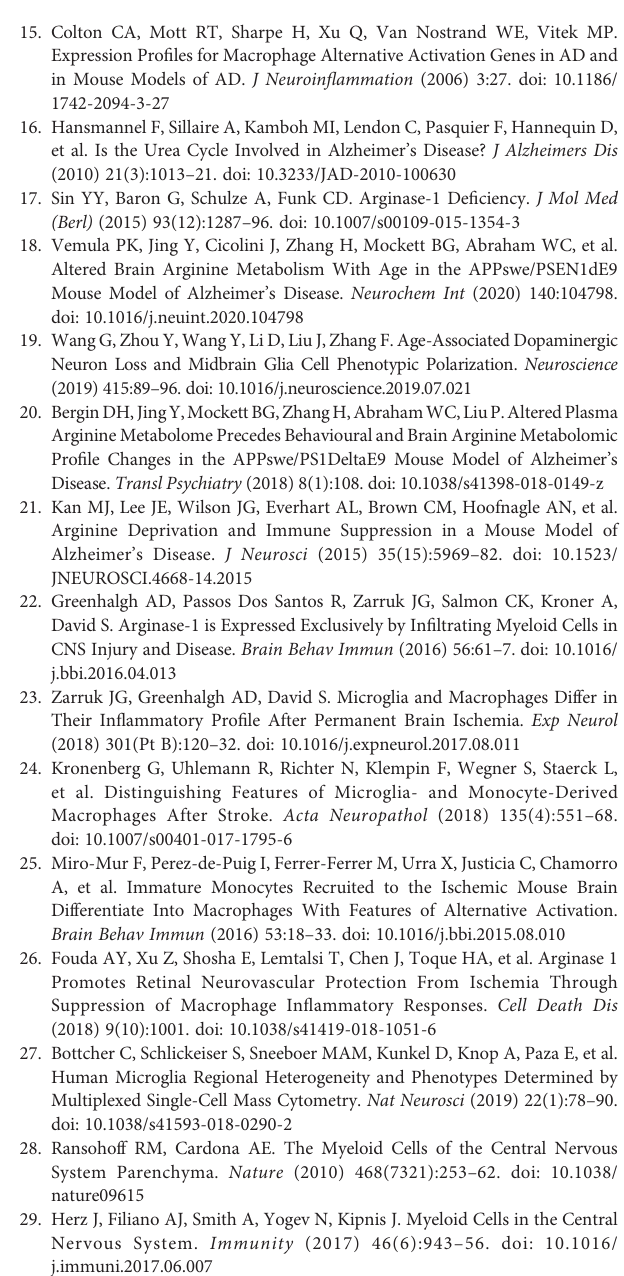
unsupervised clustering of 770 genes. All data passed QC metrics without any fl ags (top bar, yellow). Genes expressed below the background threshold are fl agged in blue.Theorangeorbluecolorintheheatmapindicateshighorlowgeneexpression z -score of each sample. All scores are presented on the same scale via a z - transformation. (B) Principal components of all normalized data. The principal component analysis shows the four groups ’ variance using the four leading componentsbasedonallnormalizeddata. (C) Aheatmapofcorrelation matrixofall signature pathways from pathway scoring analysis was presented. Yellow and blue colors indicate positive and negative correlation and thus aggregate separately. Pathways that show statistically signi fi cant main APP transgene genotype effects are highlighted in red or blue text to indicate up or down-regulation,